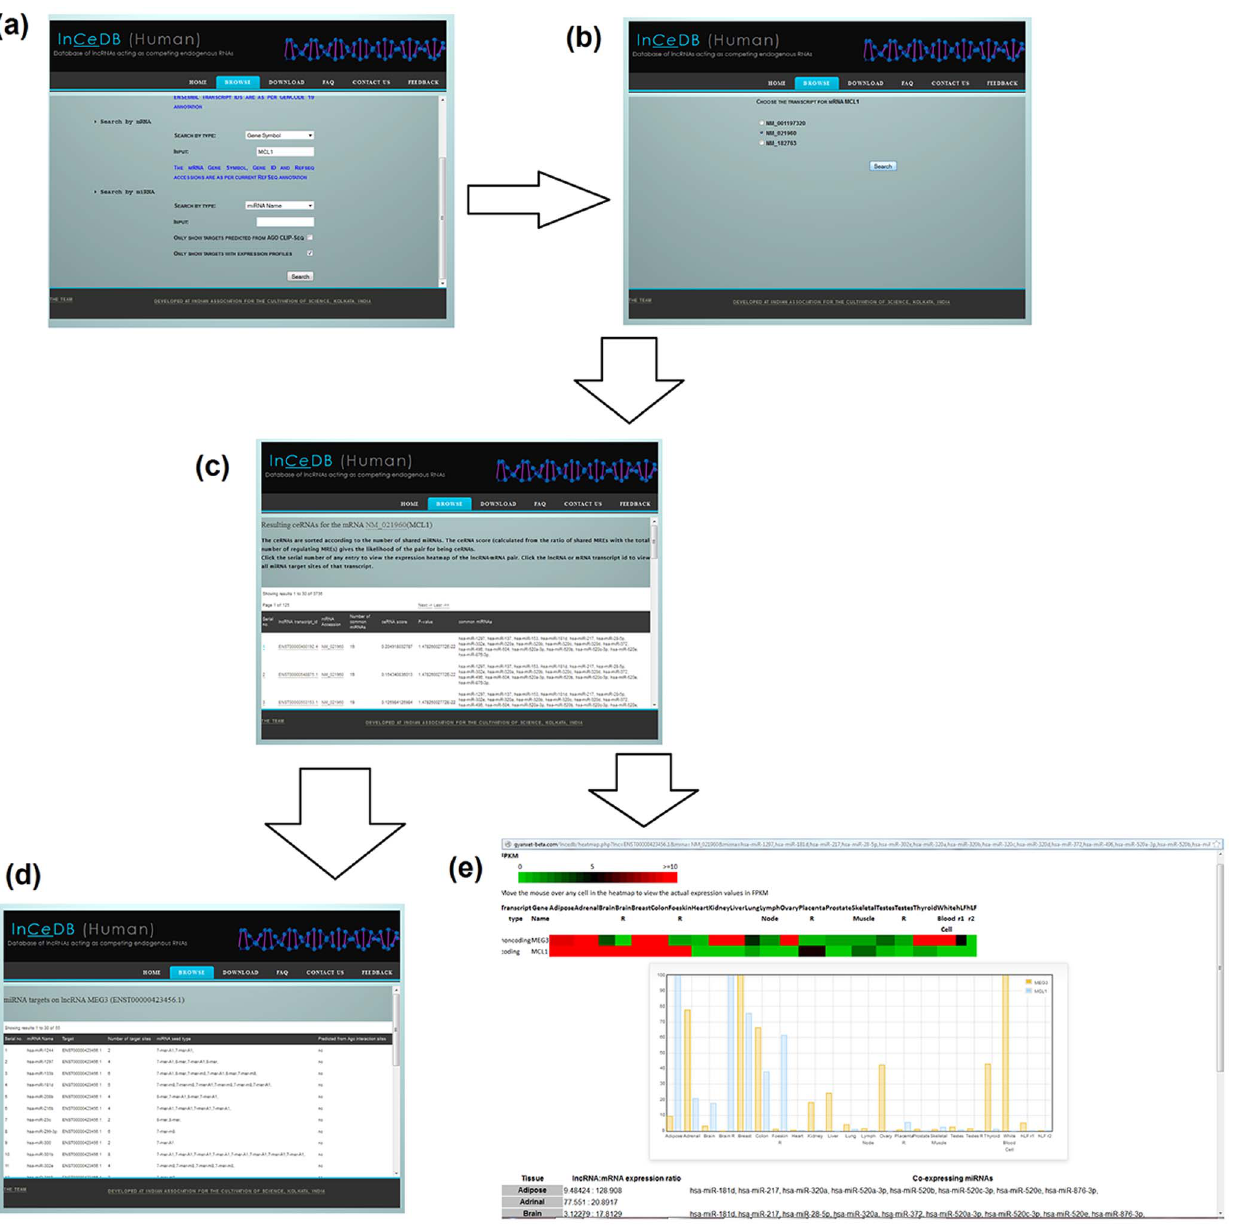
Figure 2. The flow diagram for browsing ceRNAs in ln Ce DB. (a) lnCeDB is searched by the gene symbol MCL1. (b) An intermediate page shows the different transcripts of the gene MCL1. (c) Upon choosing a transcript, the results page shows the potential lncRNAs working as ceRNA for the chosen transcript of MCL1. (d) By clicking on a lncRNA or mRNA id in the ceRNA table, the user views all miRNA targets on the chosen transcript. (e) By clicking on a serial number in the ceRNA table, the user views the expression heatmap and bar chart for the ceRNA pair along with co- expressed shared miRNAs in 22 human tissues.